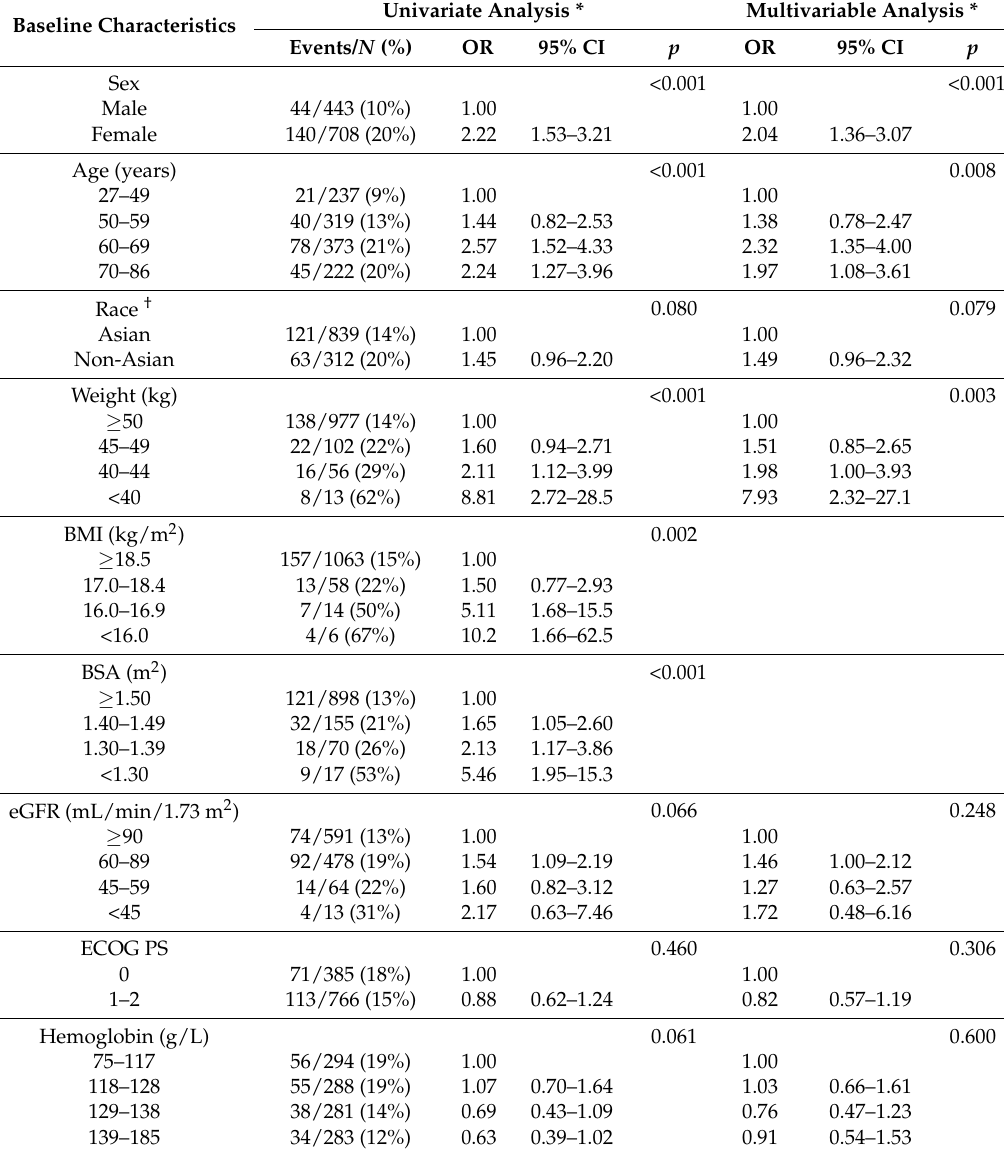
Table 2. Logistic regression analysis * of association between pre-treatment characteristics and grade ≥ 3 diarrhea with